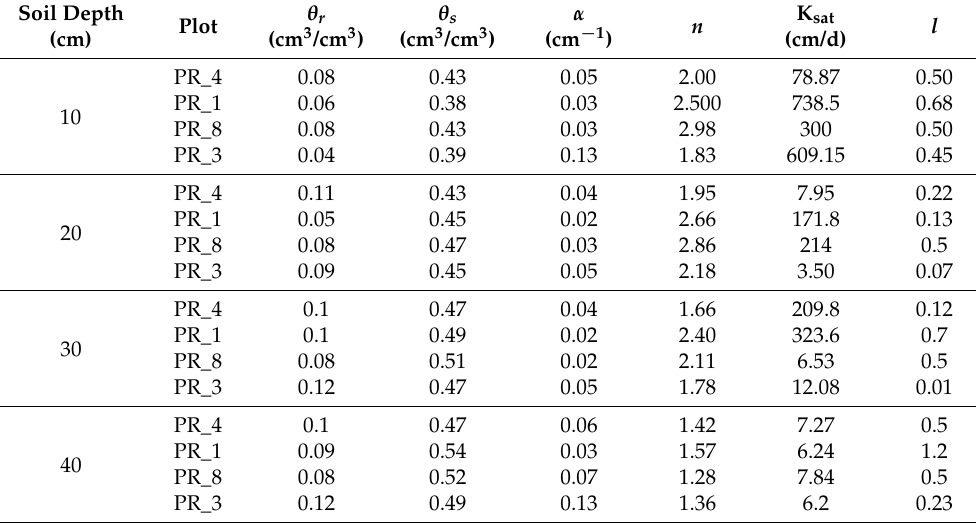
Table 3. Calibrated van Genuchten hydraulic parameters for the different plots at the riparian zone of the